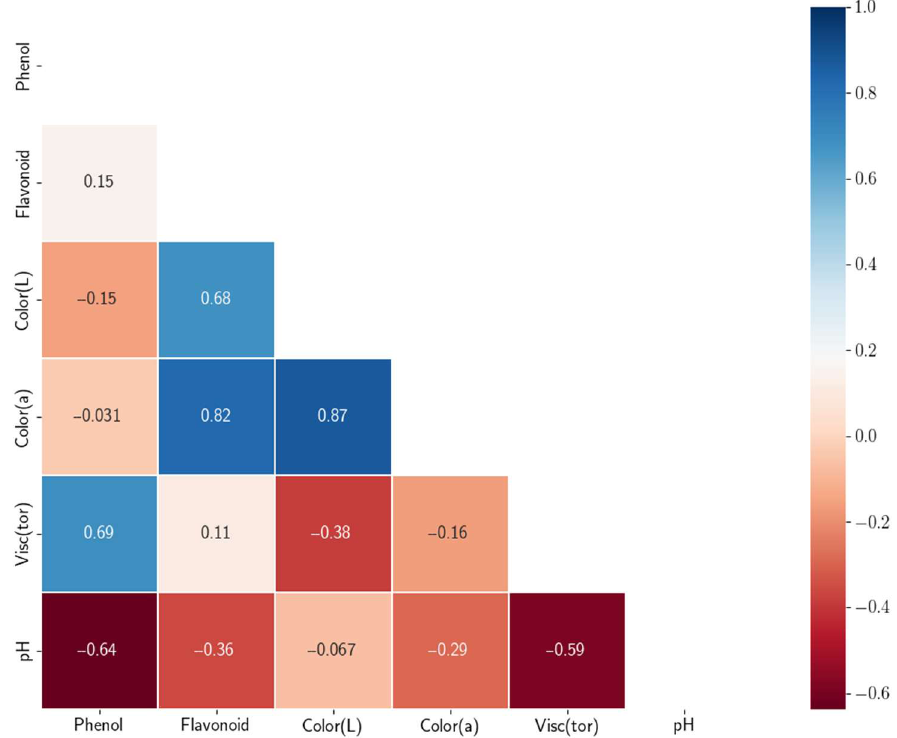
Figure 13. Parameter pair correlations.